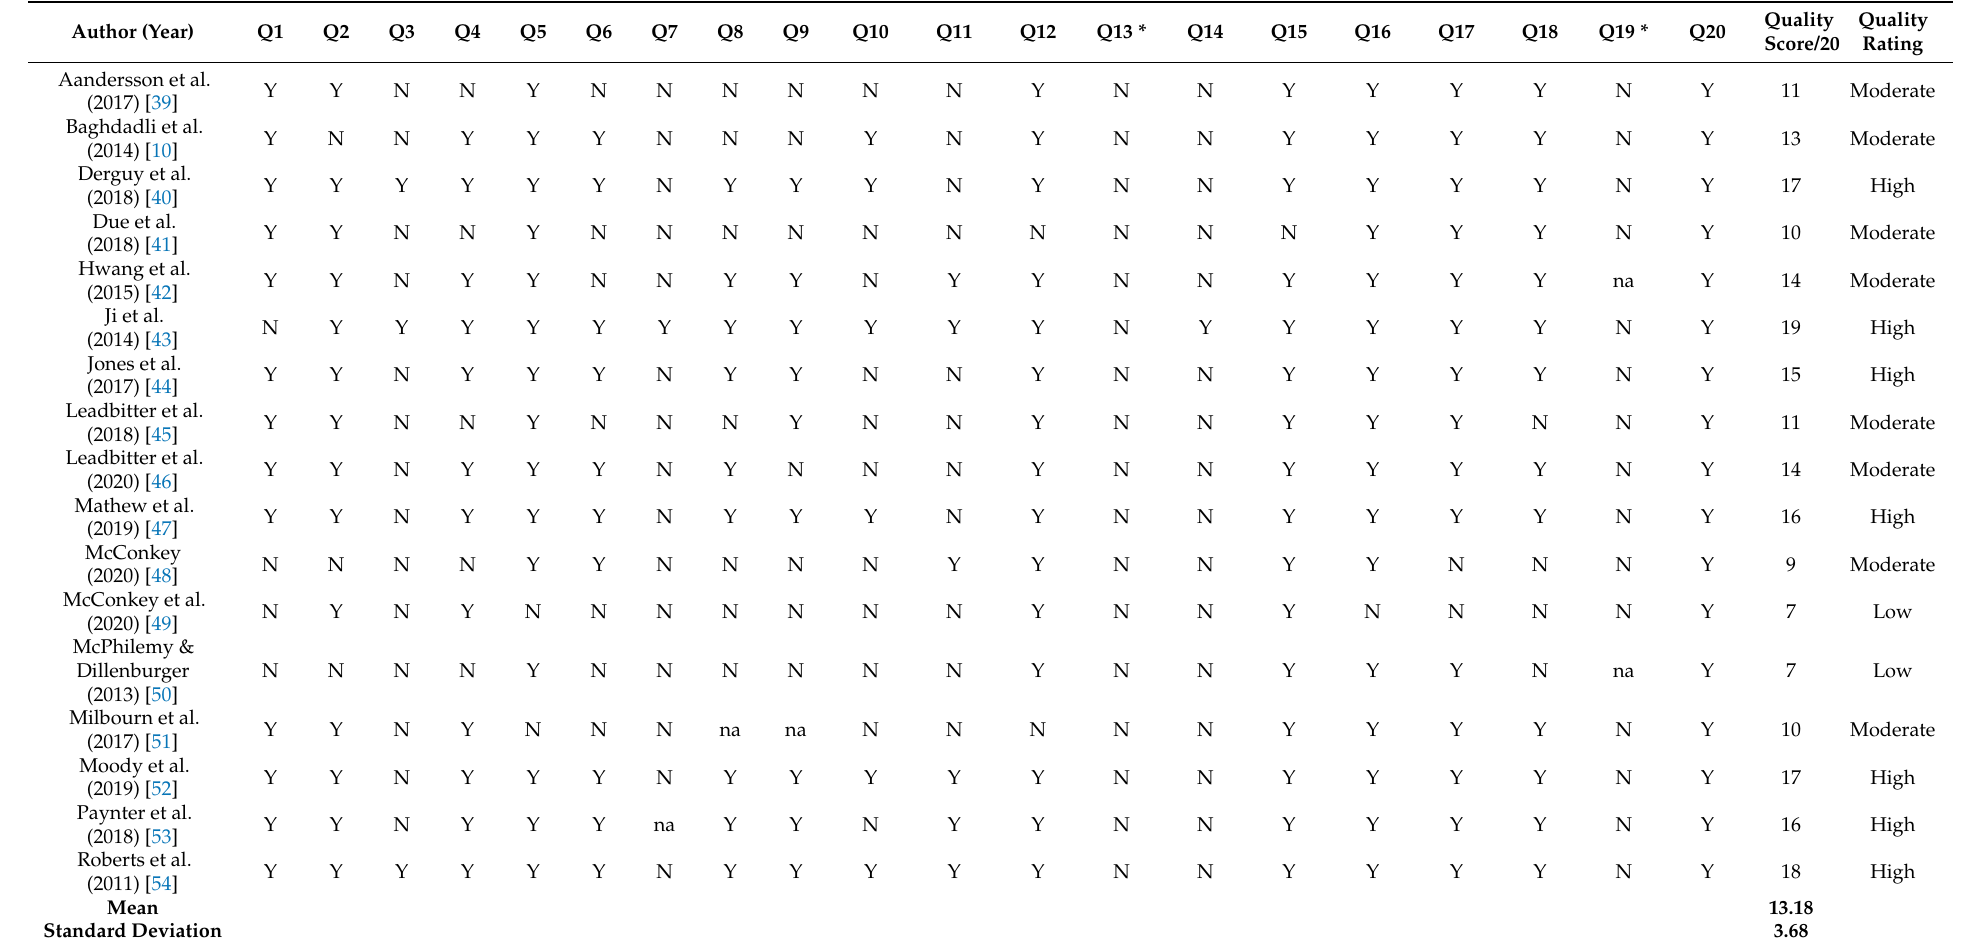
Table 3. Quality assessments and total scores using the Appraisal Tool for Cross-Sectional Studies